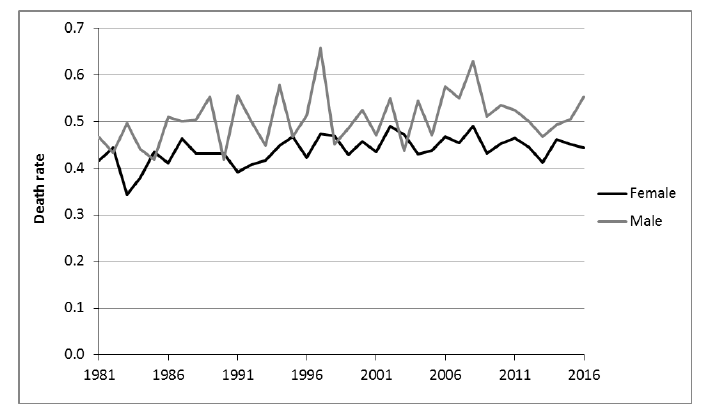
Figure 6: Centenarian death rates, 1981-2016